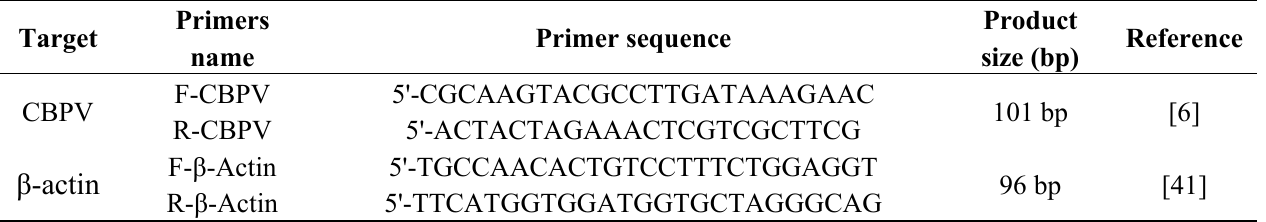
Table 3. Primers used for CBPV and β-Actin